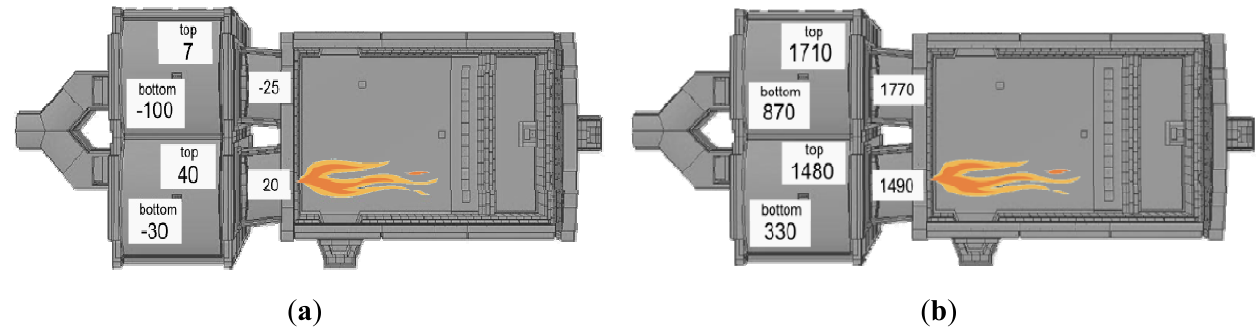
Figure 3. Experimental data of a standard End Port regenerative chamber ( a ): relative pressure [Pa]; ( b ): temperature